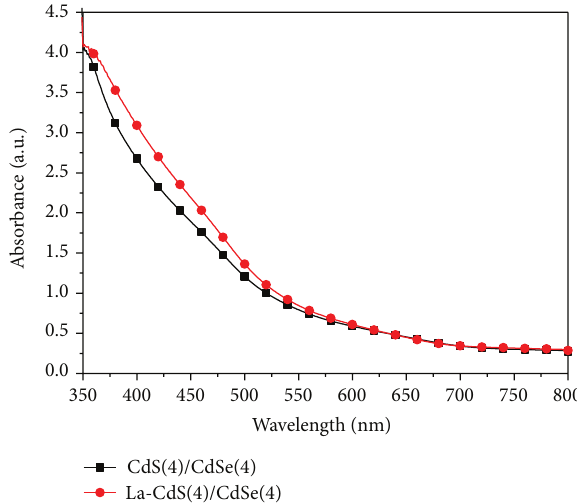
Figure 8: The absorption spectrum around doped CdS calculated by using (𝛼ℎ ] ) 2 = ℎ ] − 𝐸 𝑔